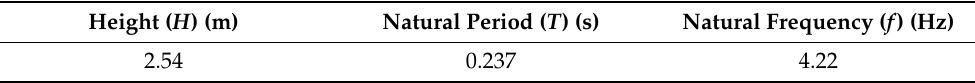
Table 1. Information of a full-scale free-form structure.